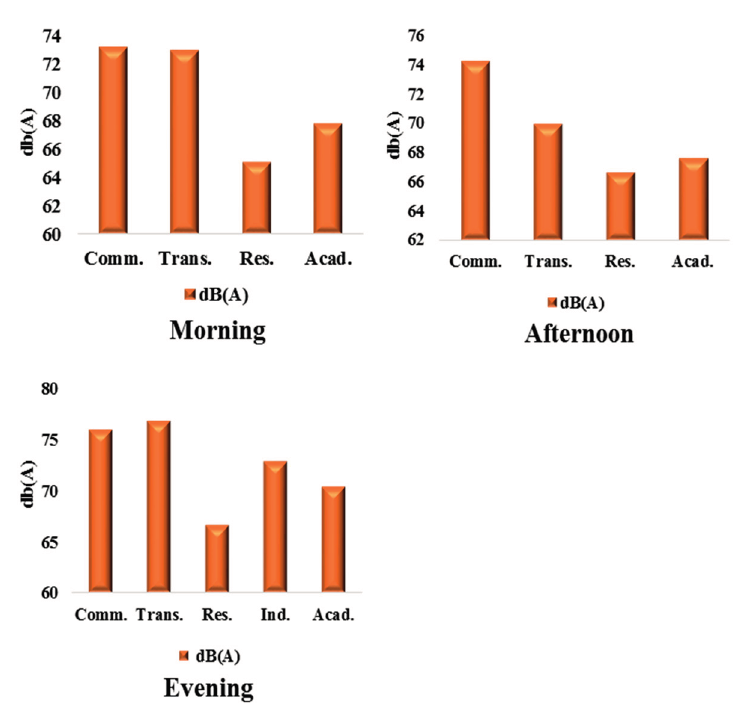
Figure 10. Average noise levels and land use in